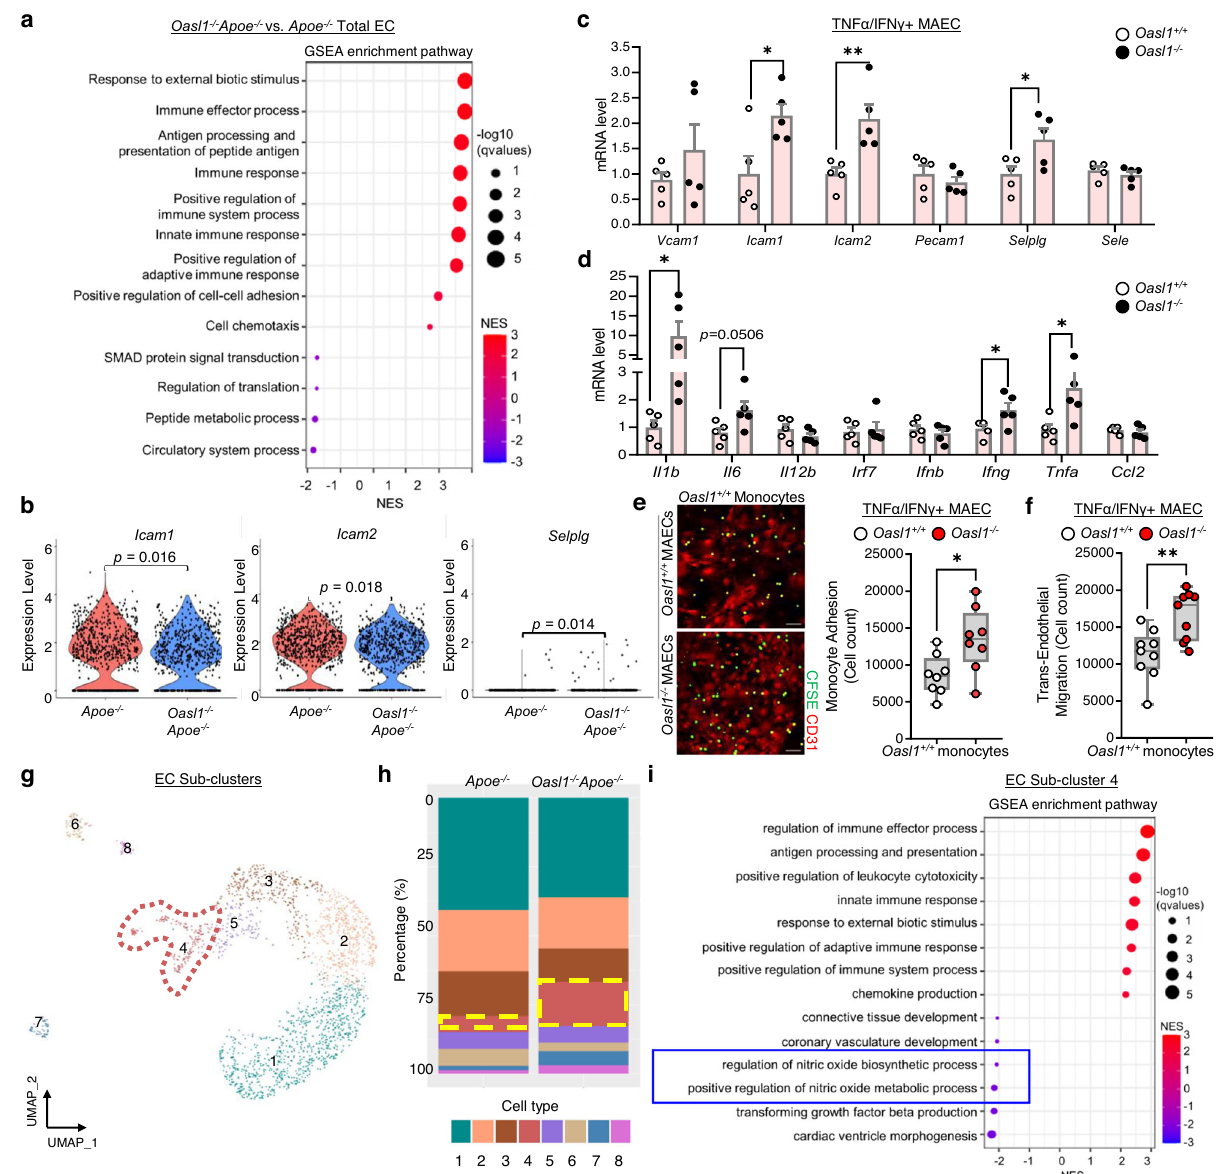
Fig.4| Oasl1 de fi ciencydown-regulatesNOsynthesisandpromotesendothelial in fl ammation.a DotplotshowingGeneSetEnrichmentAnalysis(GSEA)according tonormalizedenrichmentscore(NES)forGeneOntology(GO)termsofthetotalEC clusterfrom Oasl1 − / − Apoe − / − miceversusthatof Apoe − / − mice. b Violinplotshowinga comparison of the adhesion molecules, Icam1, Icam2 , and Selplg , in the aortic EC cluster of Oasl1 − / − Apoe − / − versus Apoe − / − mice. c , d Quantitative PCR analysis of the adhesion molecules, Vcam1 ( p =0.2965), Icam1 ( p =0.0264), Icam2 ( p =0.0080), Pecam1 ( p =0.4082), Selplg ( p =0.0362), and Sele ( p =0.3979) ( c ), and the proin- fl ammatory genes, Il1b ( p =0.0486), Il6 ( p =0.0506), Il12b ( p =0.2400), Irf7 ( p =0.7404), Ifnb ( p =0.4914), Ifng ( p =0.0477), Tnfa ( p =0.047) and Ccl2 ( p =0.5093) ( d ) in MAECs isolated from Oasl1 +/+ and Oasl1 − / − mice and stimulated with TNF α and IFN γ ( n =5 per group). e Assay of CFSE-labeled Oasl1 +/+ monocyte adhesion to TNF α - and IFN γ -stimulated MAECs isolated from Oasl1 +/+ and Oasl1 − / −